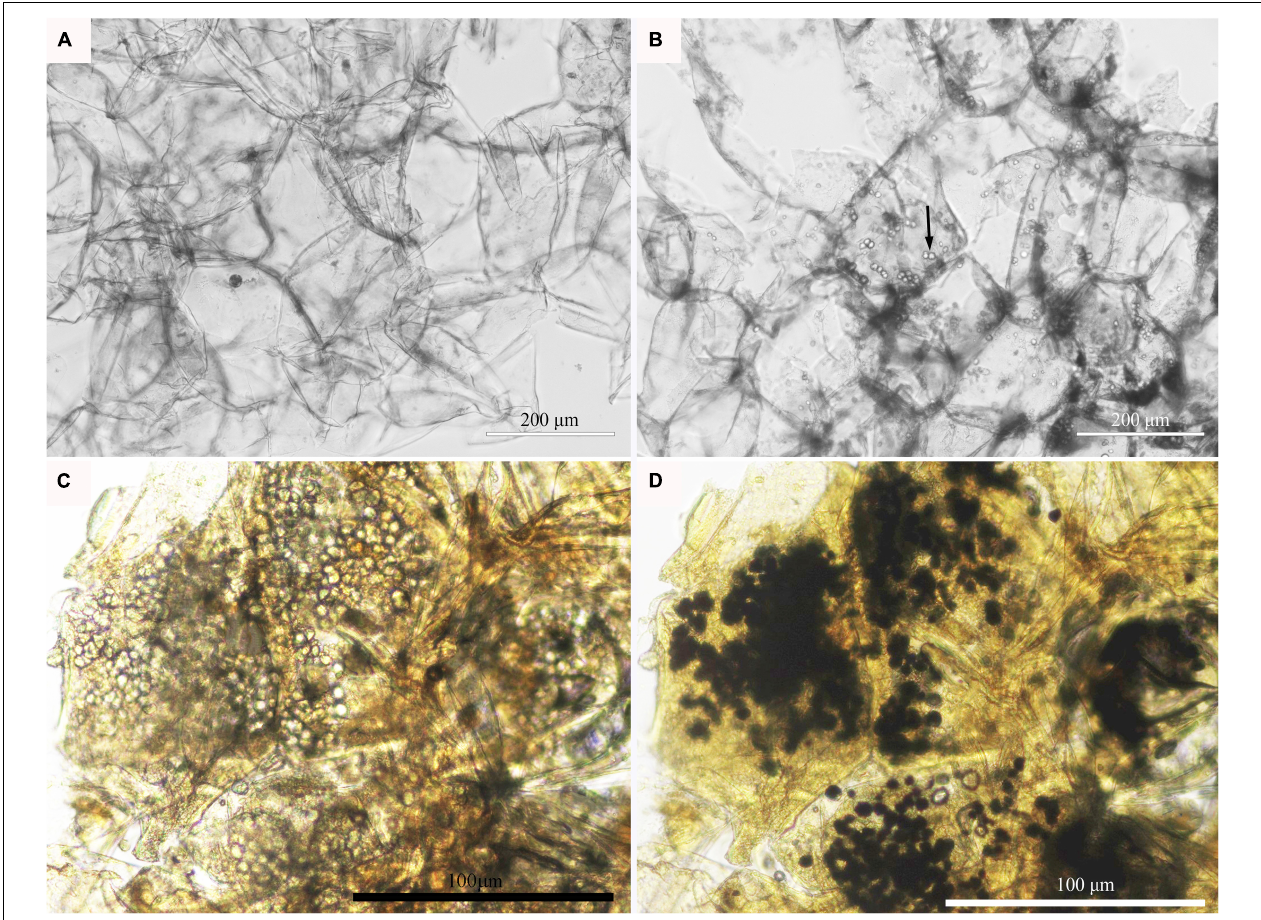
FIGURE 1 | Microscopic observation of amyloplasts in the flesh cells of apples with bitter pit. (A) The flesh of healthy fruit. (B) The bitter pit flesh; the cells contain granular substances. (C) Pulp cells from bitter pit-affected fruits without I 2 -IK staining. (D) Pulp cells from bitter pit-affected fruits stained with I-IK. Granular material is shown in black and purple. The magnification of the objective of the microscope is 20 times.